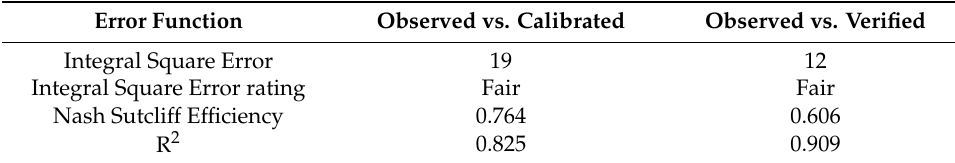
Table 4. Calibration of peak flow.